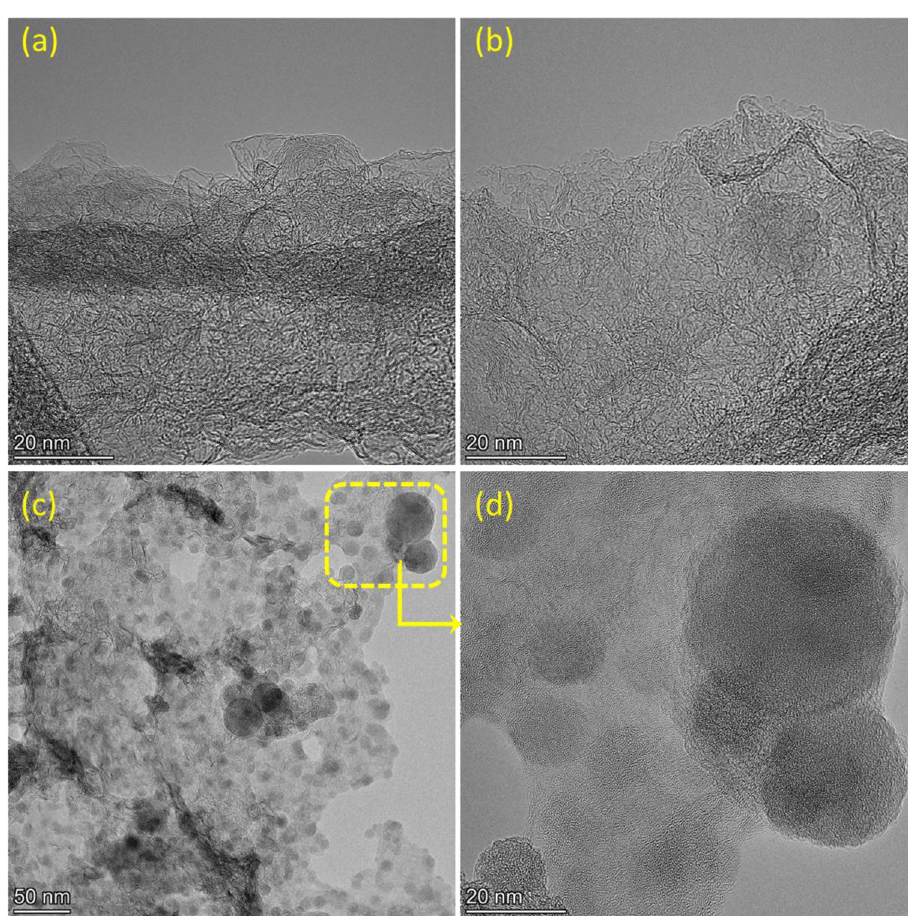
Fig. 3 Structure via transmission electron microscopy. a , b High-resolution TEM images of graphene-like structures obtained after Kapton foil PI decomposition. c Low magni fi cation, and d HR-TEM images of graphene/SiO x nanohybrids arising from Kapton tape (PI/silicone adhesive) laser-assisted